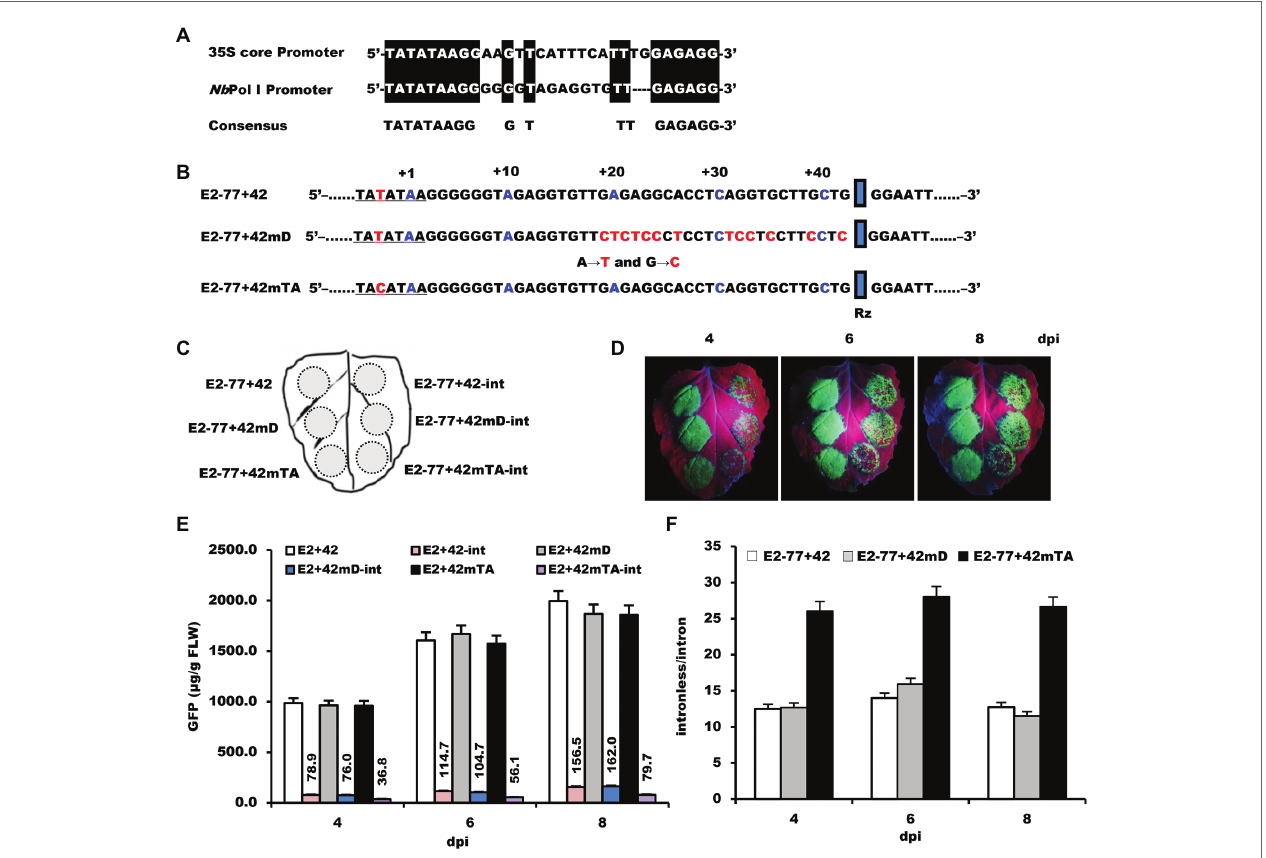
FIGURE 6 | The effects of mutation of Nb rRNA core promoter on its transcription specificity. (A) Alignment of 35S and Pol I core promoter. (B) The nucleic acid sequences and the mutation position of the E2 − 77+42 promoter. (C) Schematic representation of the agroinfiltrated zones in N. benthamiana leaf. (D) GFP expression pattern (under UV light) of agroinfiltrated N. benthamiana leaves at 4, 6, and 8 dpi, respectively. (E) Time course for the accumulation of GFP in infiltrated leaves by ELISA. (F) The ratios of GFP accumulation between intronless/intron-containing